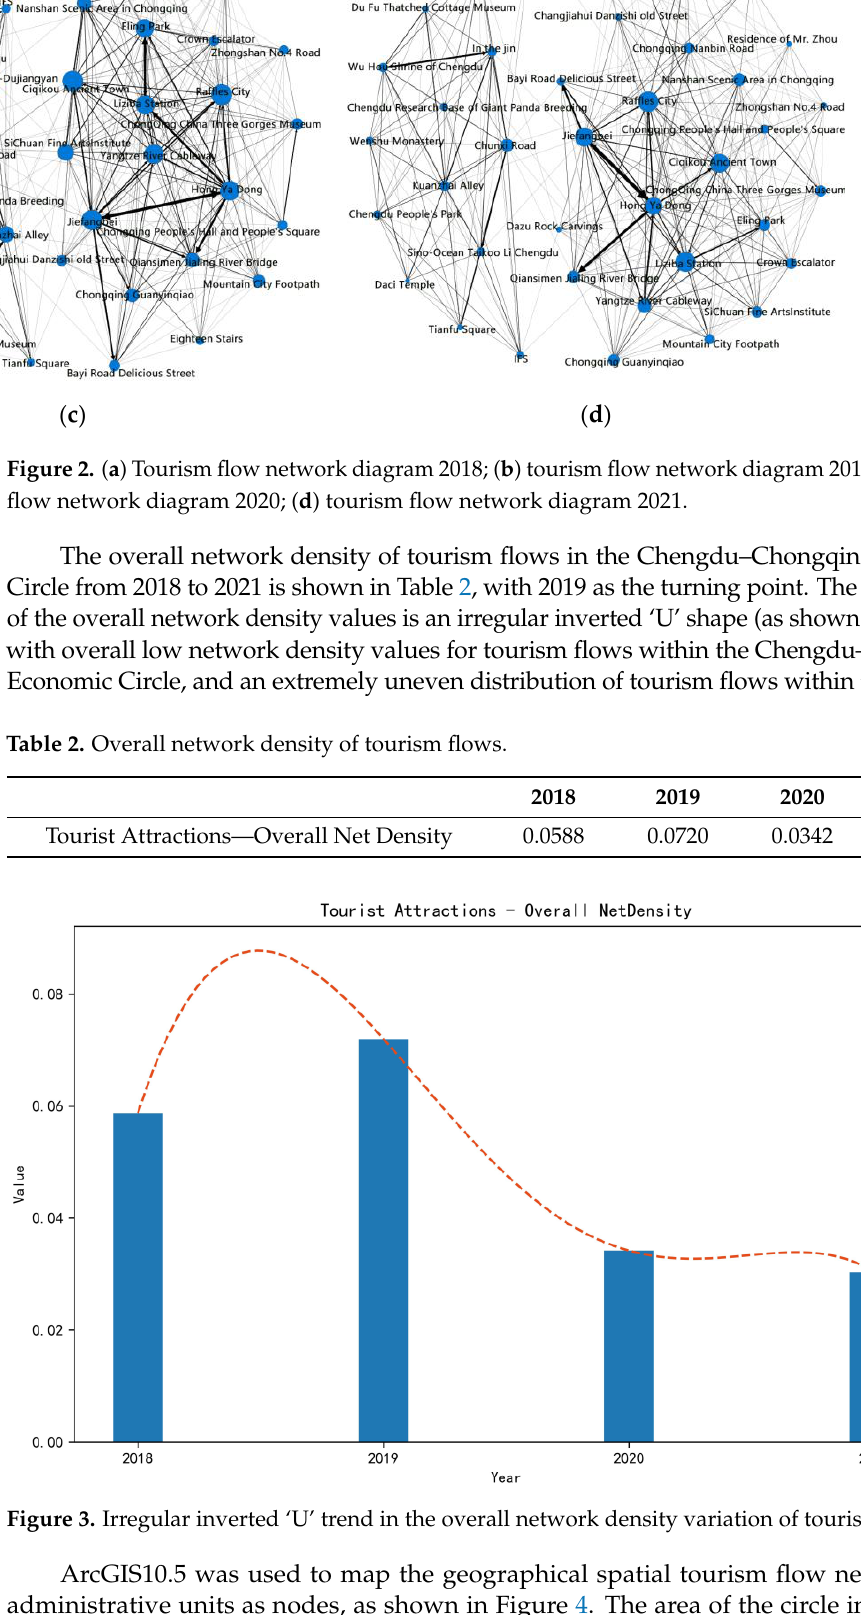
Figure 3. Irregular inverted ‘U’ trend in the overall network density variation of tourism flows. ArcGIS10.5 was used to map the geographical spatial tourism flow network with administrative units as nodes, as shown in Figure 4. The area of the circle indicates the rela- tive size of the sum of inflow and outflow, and the thickness of the line with arrows be- tween the nodes indicates the relative size of the directed inflow. The thicker the line, the closer the connection between the nodes.